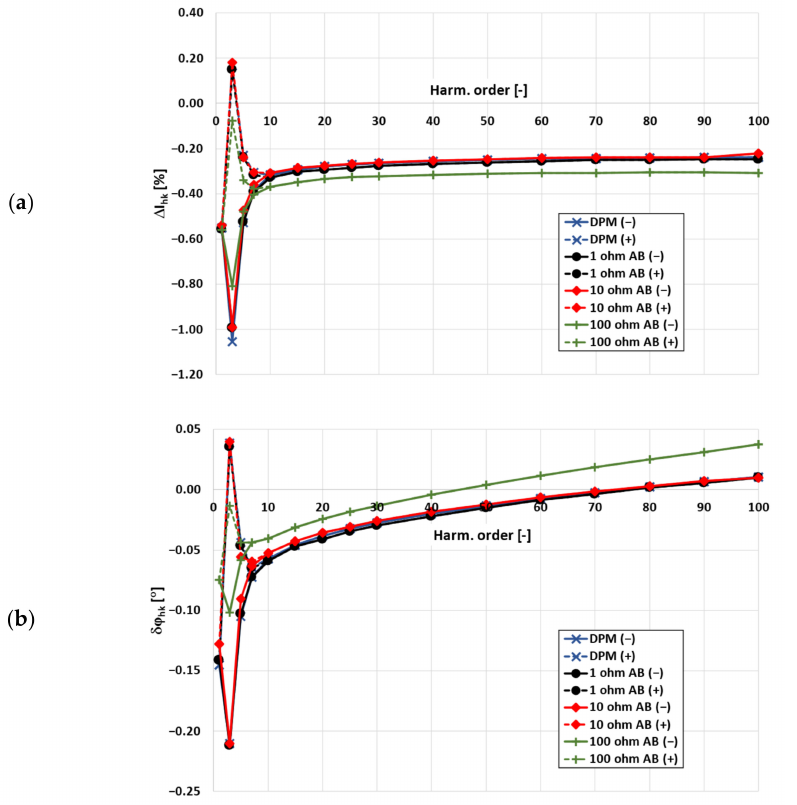
Figure 3. The influence of the self-generated low-order higher harmonics of the tested wideband CT and current shunt resistance on current error ( a ) and phase displacement ( b ) for rated primary current and load resistance. In Figure 3, the following abbreviations are used: DPM (+) \ ( − )—maximum positive (dashed line)/maximum negative (solid line) values of current error and phase displacement determined by the digital power meter (DPM), 1 \ 10 \ 100 ohm AB (+) \ ( − )—maximum positive (dashed line)/maximum negative (solid line) values of current error and phase displacement determined by the digital acquisition board (AB) using a current shunt of 1 Ω \ 10 Ω \ 100 Ω